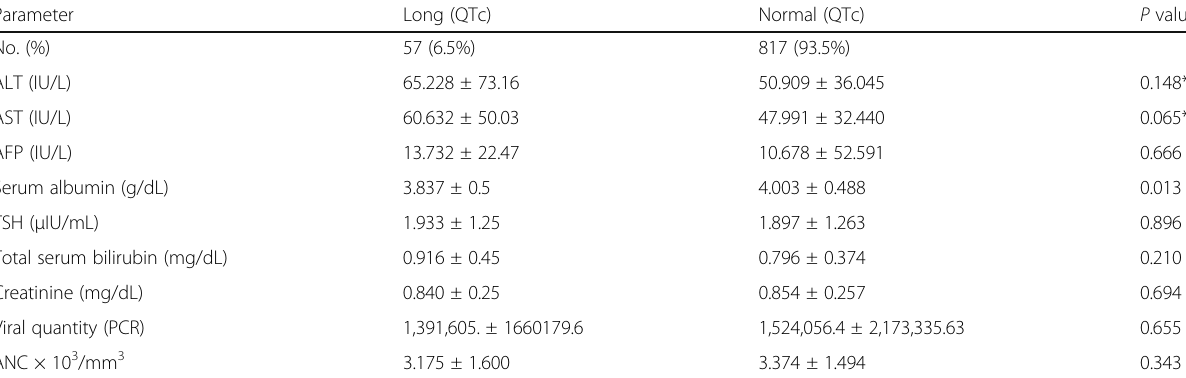
Table 2 The laboratory tests done for the studied patients Parameter